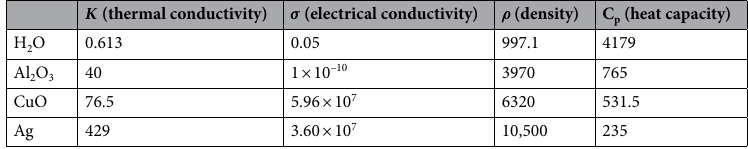
Table 1. Thermal properties 89,90 of nanoparticles (Al 2 O 3 , CuO and Ag) in H 2 O.